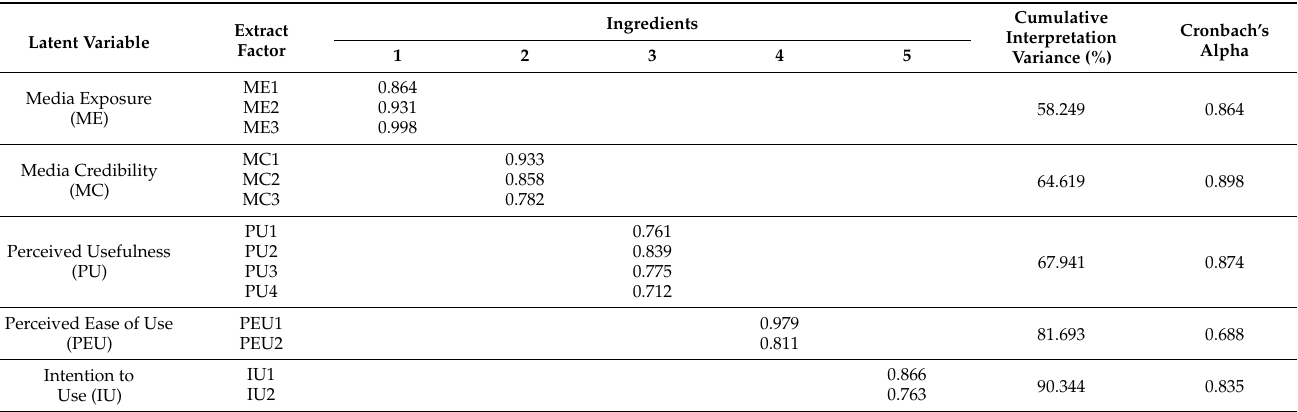
Table 3. Exploratory factor analysis